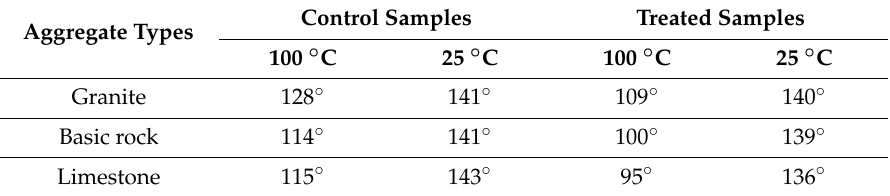
Table 5. The test results of contact angles for different aggregates with #90 asphalt.